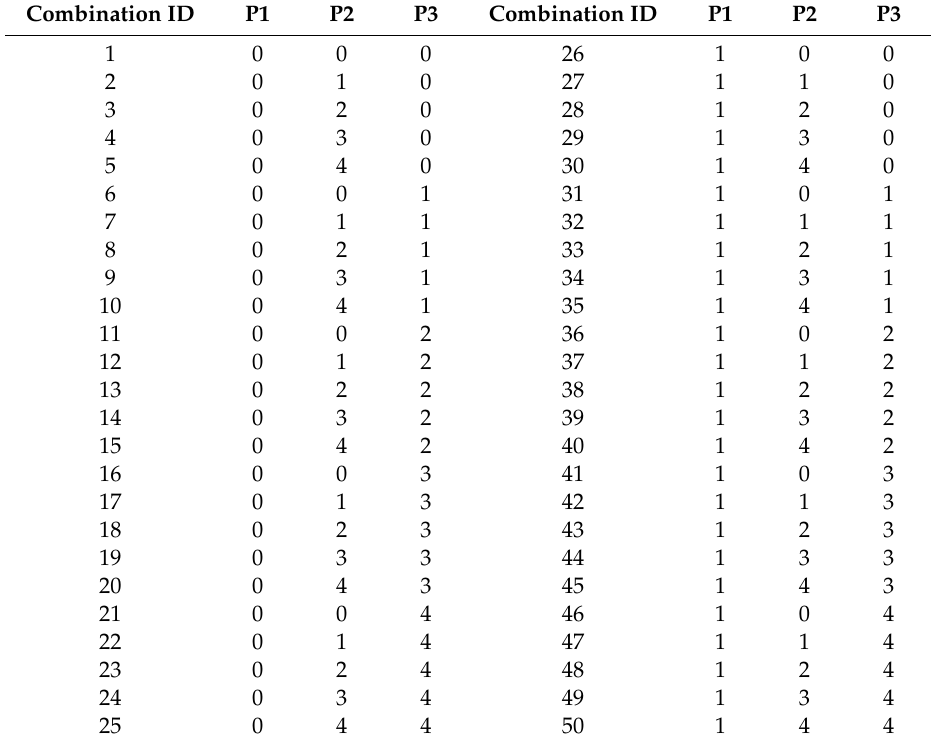
Table 2. Combinations of numbers of Sentinel-2 (S2) LAI images used for assimilation into the model during di ff erent phenophases. P1: principal growth phase tillering (DVS < 0.44), P2: principal